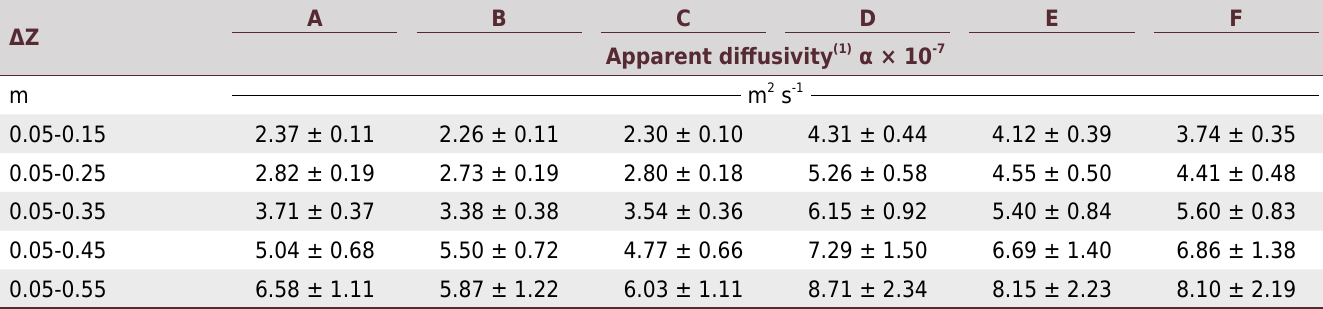
Table 1. Apparent diffusivity calculated α × 10 -7 (m 2 s -1 ) with their respective error ranges at different soil depths in April 2013 (A, B, and C) and August 2013 (D, E, and F) A ΔZ